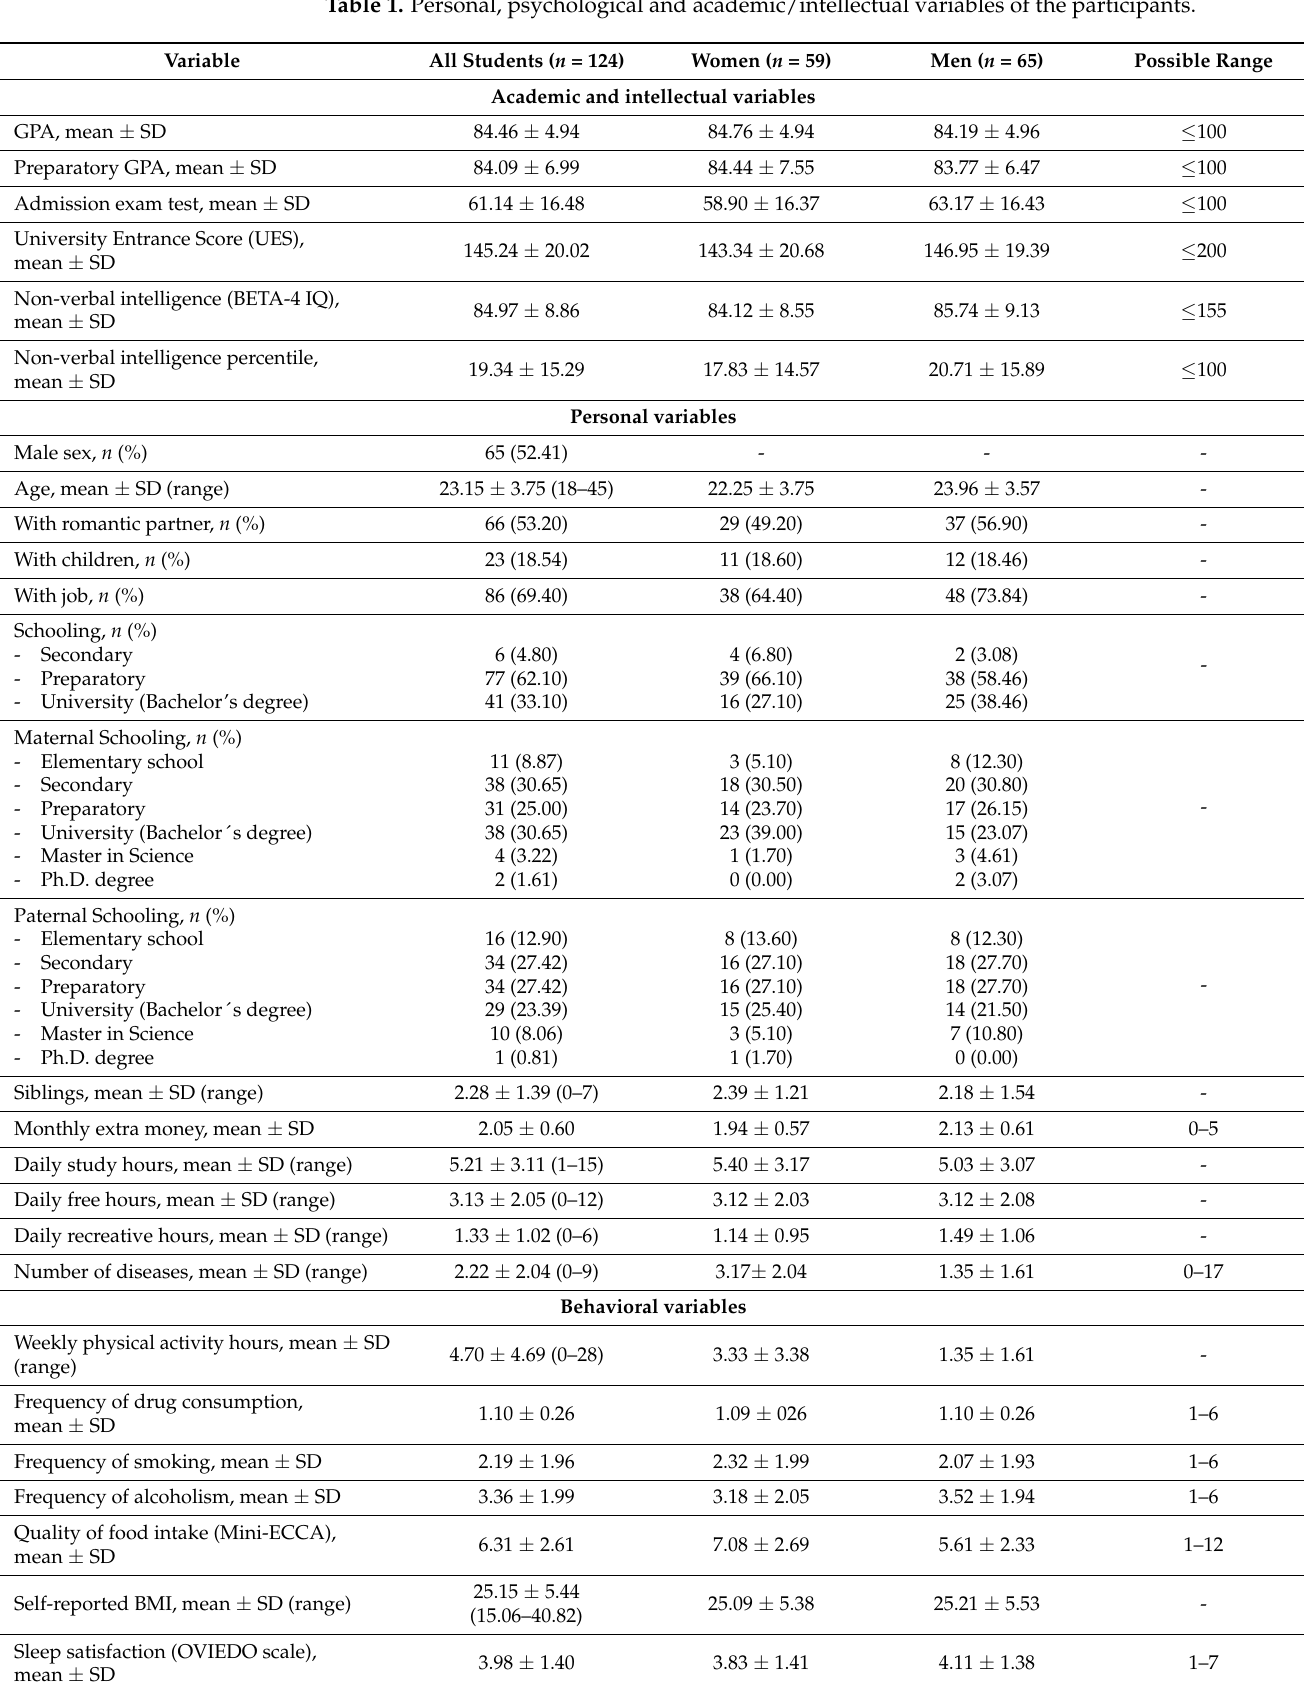
Table 1. Personal, psychological and academic/intellectual variables of the